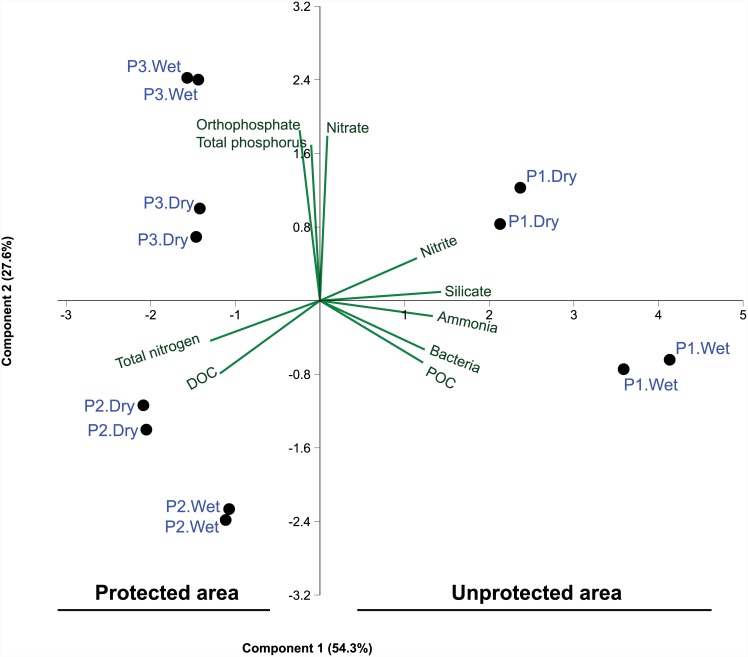
Principal component analysis (PCA) of the physicochemical parameters and bacterial community of Paraguaçú River water samples obtained from three sites (P1, unprotected area; P2 and P3, protected areas) during both wet and dry seasons.The ordination analysis was performed with ammonia, nitrite, nitrate, total nitrogen, orthophosphate, total phosphorous, silicate, dissolved organic carbon (DOC), particulate organic carbon (POC), and bacterial counts based on the correlation matrix.